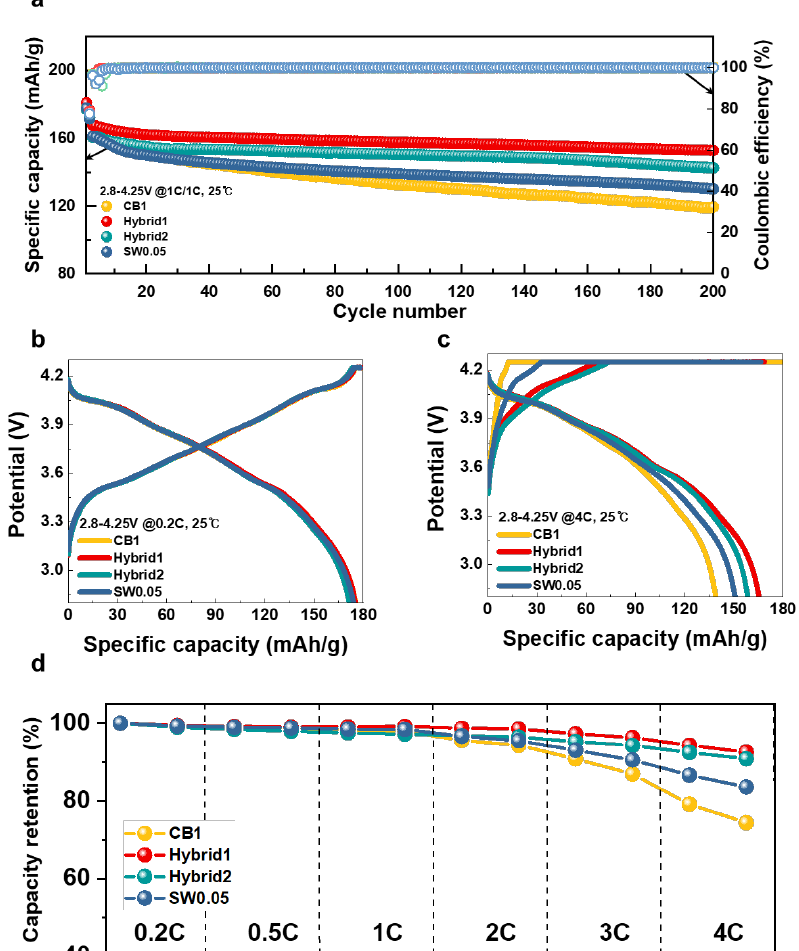
Figure 4. Characterization of electrochemical properties of full cells: ( a ) cycle performance during 200 cycles; ( b ) charge/discharge curves at 0.2 C; ( c ) charge/discharge curves at 4 C; and ( d ) rate cycling performance from 0.2 C to 4 C.